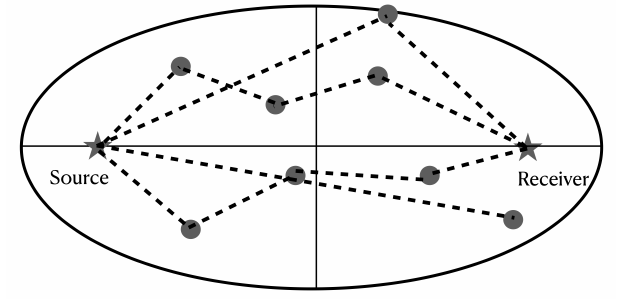
Figure 3. Energy particles emitted by the source travel (dashed paths) inside the scattering ellipse, following the Fermat’s rules. Collisions with heterogeneities are marked with dark grey circles. When arrived at the Receiver, the particles are counted and a time histogram is